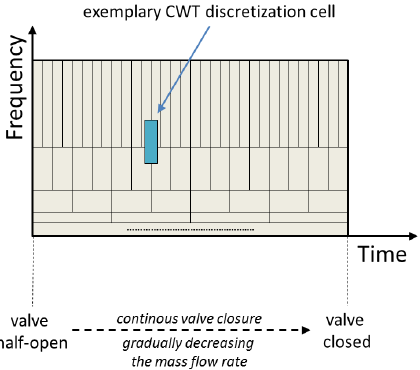
Figure 4: Scheme demonstrating the method used in dynamic tests.